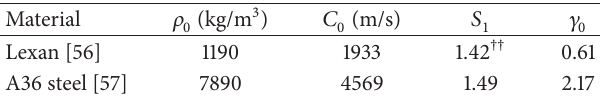
Table 4: EOS parameters for the projectile and the target.